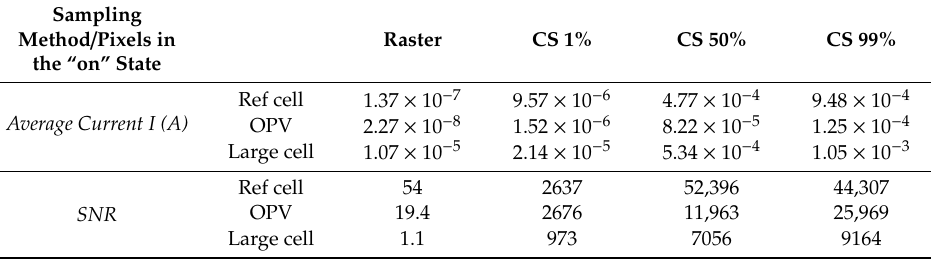
Table 1. Average current values and signal-to-noise ratio (SNR) for di ff erent samples and sampling methods. Sampling Method / Pixels